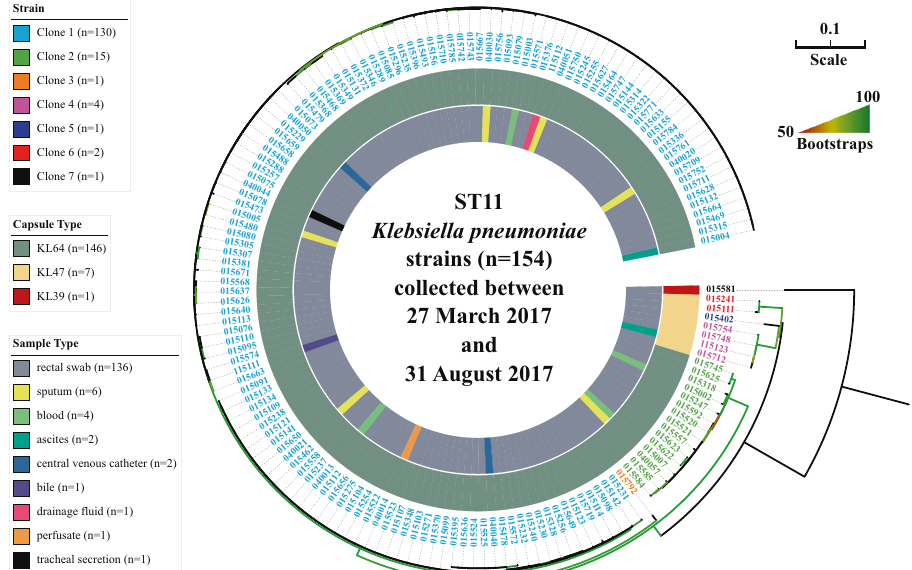
Fig. 2 Phylogenomic tree of ST11 CRKP isolates ( n = 154) collected in this study. The tree was inferred using strain 015093 as the reference. Information on the strains is available in Supplementary Dataset 1 and Dataset 2. The numbers of SNPs are shown in Supplementary Dataset 3. The phylogeny was inferred from core SNP sites under GTR model with site rate variation and a 1,000-bootstrap test. The tree was midpoint- rooted with bootstrap support over 50% shown in gradients. Strains from 7 well-separated clones were labelled with distinct colors which were clari fi ed in the top-left